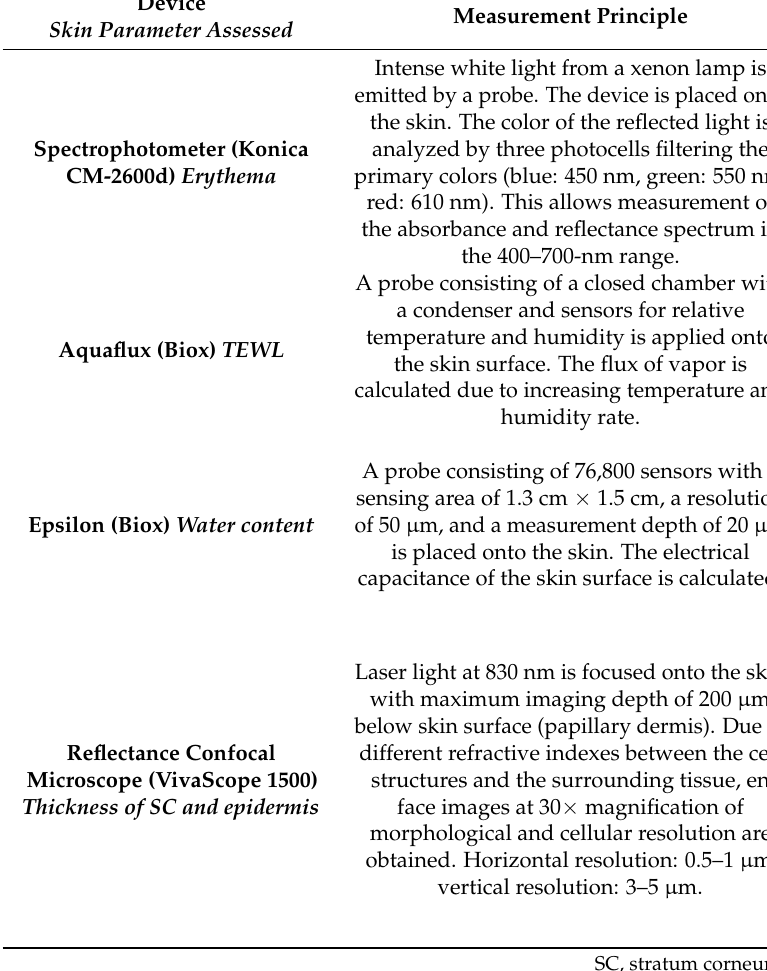
Table 2. Overview of the four devices used for the skin barrier function